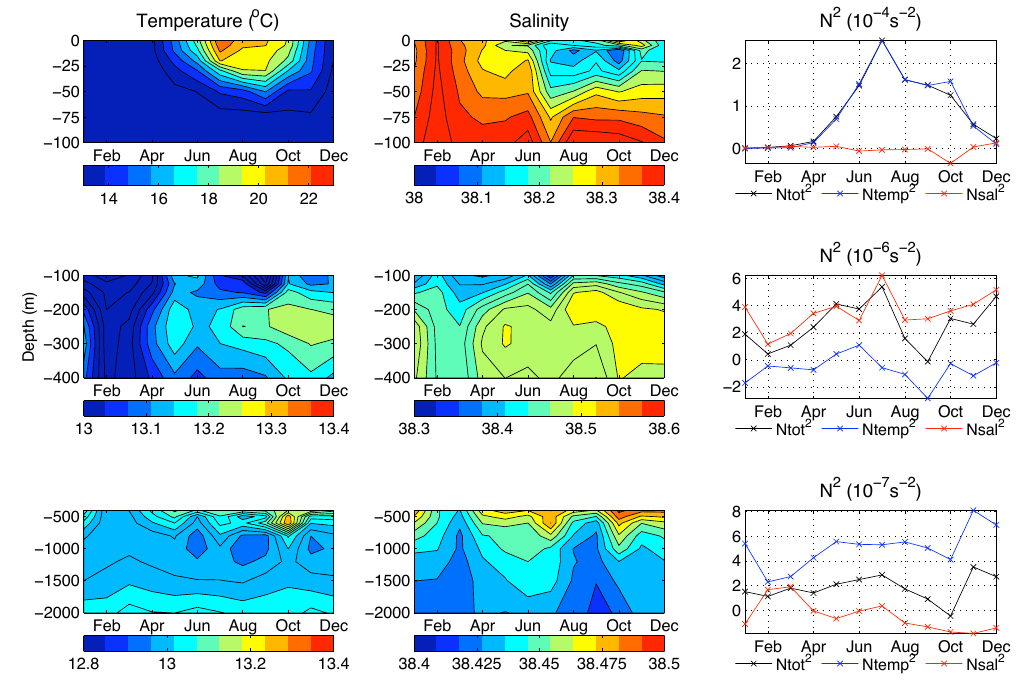
Fig. 2. Temperature (left), salinity (centre) and mean vertical buoyancy gradient (right – see text for definition of N 2 tot , N 2 temp and N 2 for the top (0–100m), intermediate (100–400m) and deep (below 400m) layers, over time (months) on the horizontal and depth (m) on the vertical, for the Medar data in the convective